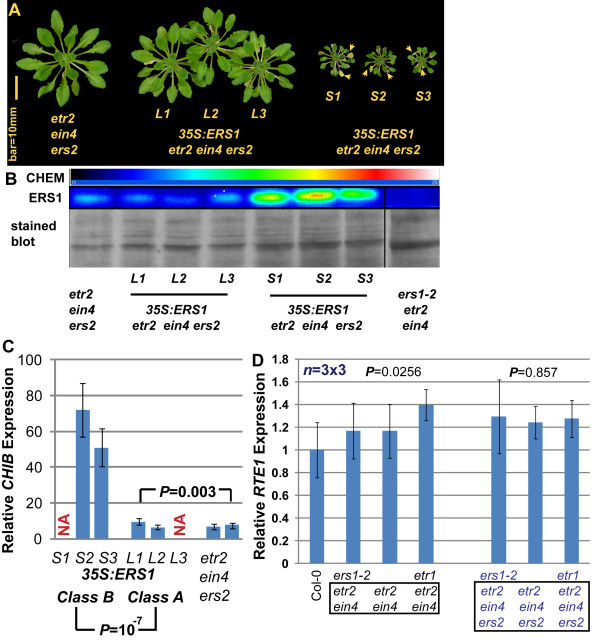
Effect of ERS1 overexpression on etr2 ein4 ers2. (A) adult phenotype of etr2 ein4 ers2, class A (L1, L2, and L3) and class B (S1, S2, and S3) lines carrying the 35S:ERS1 transgene. (B) immunoassay of ERS1 level in individual transformed lines. The ERS1 protein is not detectable in the ers1 mutant ers1-2 etr2 ein4. (C) relative CHIB gene expression in etr2 ein4 ers2 and transformed lines. (D) relative RTE1 gene expression in receptor mutants. Chemiluminance for the immunoassay was captured by a cold CCD (at -110°C and displayed in pseudo-color; the pseudo-color bar (CHEM) indicates relative signal strength from weak (dark) to strong (bright). ERS1: relative ERS1 accumulation in immunoassay probed with ERS1 antibody. Stained blot: membrane was stained with Coomassie Blue after the immunoassay to indicate relative protein amount. NA: data not available. Arrows indicate senesced leaves. Error bars indicate standard deviation. P: probability of a larger F value. n = 3 × 3: each measurement was repeated three times from three independent biological materials. Common mutations are highlighted in a box.